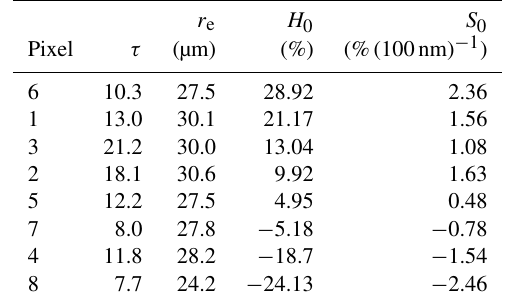
Table 1. Cloud optical thickness τ , effective radius r e , and values of H 0 and S 0 for the eight pixels highlighted in Fig. 1 (sorted by H 0 ) . For pixels 5, 6, 7, and 8, Fig. 3a shows the spectral shape of H λ